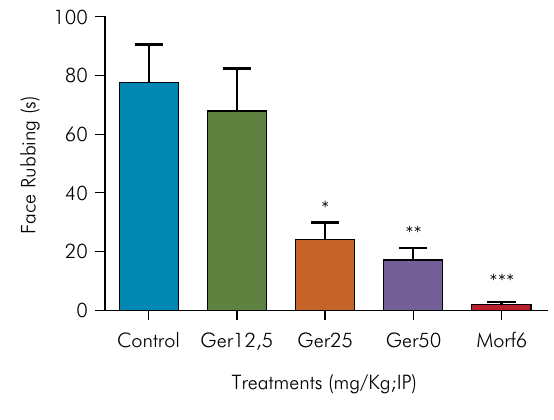
Figure 1. Effect of geraniol on glutamate-induced